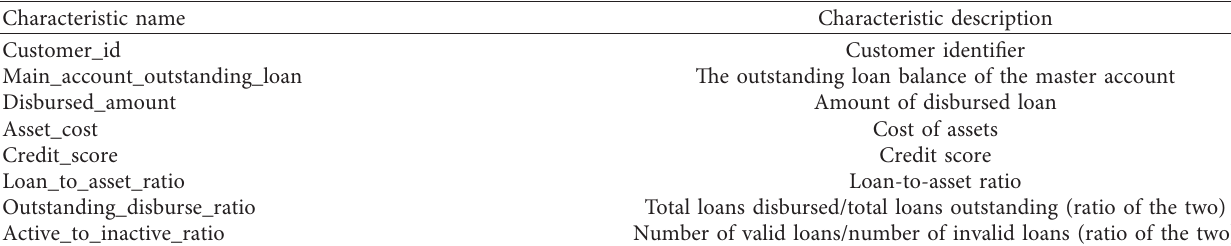
Table 1: Typical